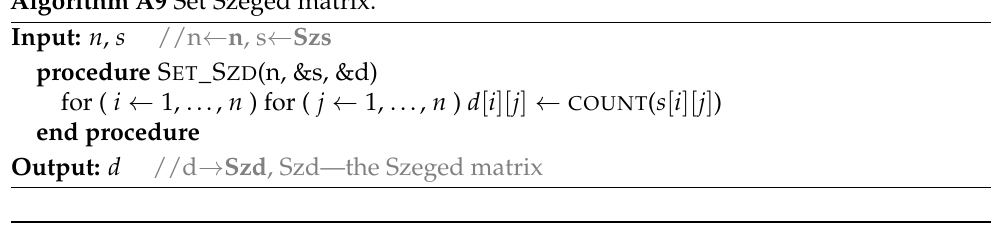
Algorithm A10 Set layer sets.